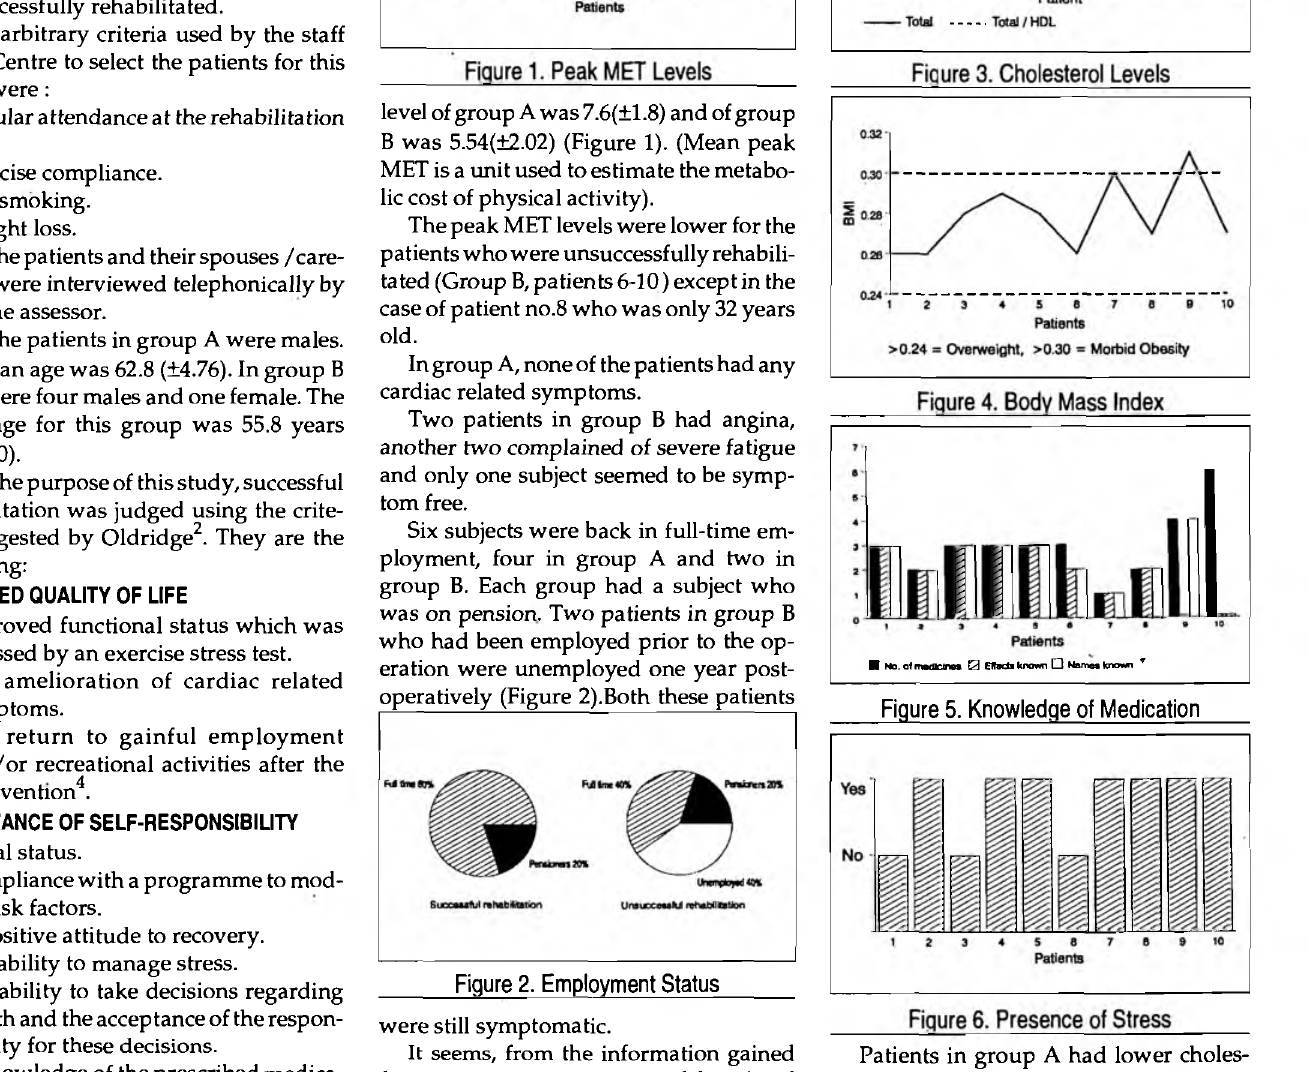
Patients in group A had lower choles­ terol levels (Figure 3) and lower body mass indices (Figure 4) than patients in group